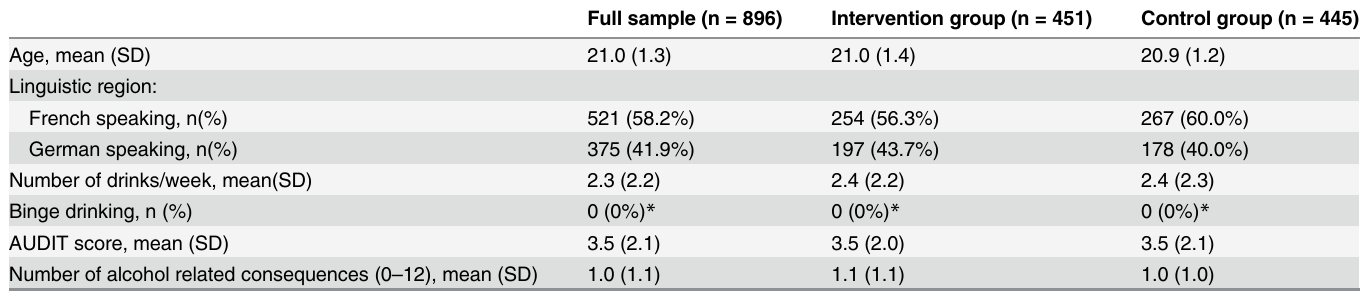
Table 1. Baseline characteristics of participants.